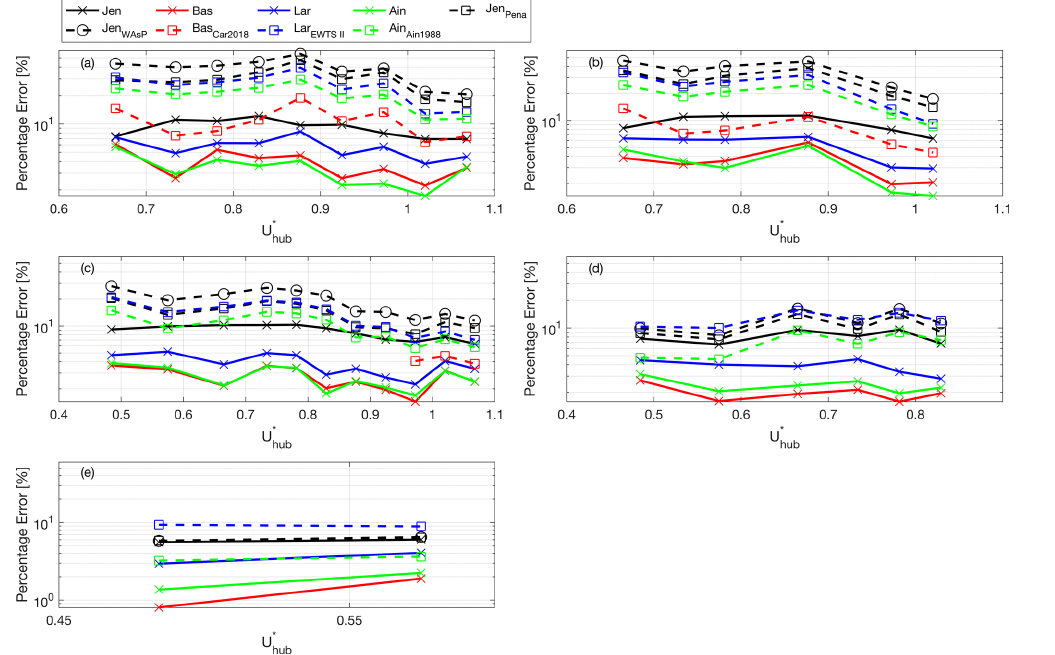
Figure 11. Percentage error, PE (Eq. 1), for four optimized wake models (solid lines) and models tuned with values from the literature (dashed lines). Different panels include data with TI: (a) 4% < TI < 5 . 5%; (b) 5 . 5% < TI < 7 . 0%; (c) 7 . 0% < TI < 13 . 5%; (d) 13 . 5% < TI < 19 . 4%; (e) 19 . 4% < TI < 35 .